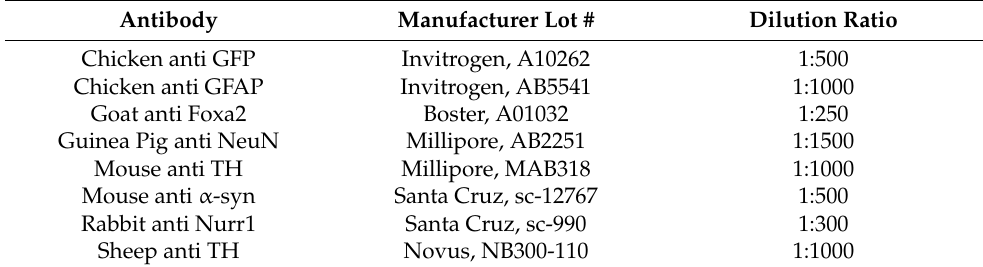
Table 1. The manufacturer, the lot number (#), and the working solution used for each antibody used in this